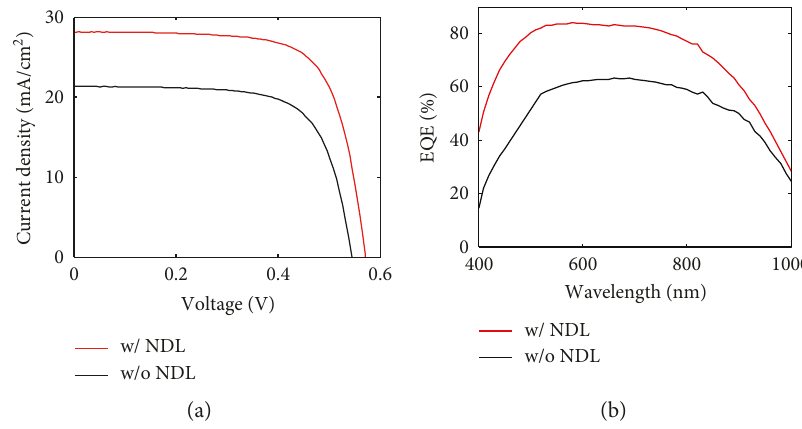
Figure 7: (a) J-V characteristics and (b) EQE characteristics of the solar cells with NDL (red) and without NDL (black). Table 1: Summary of solar cell